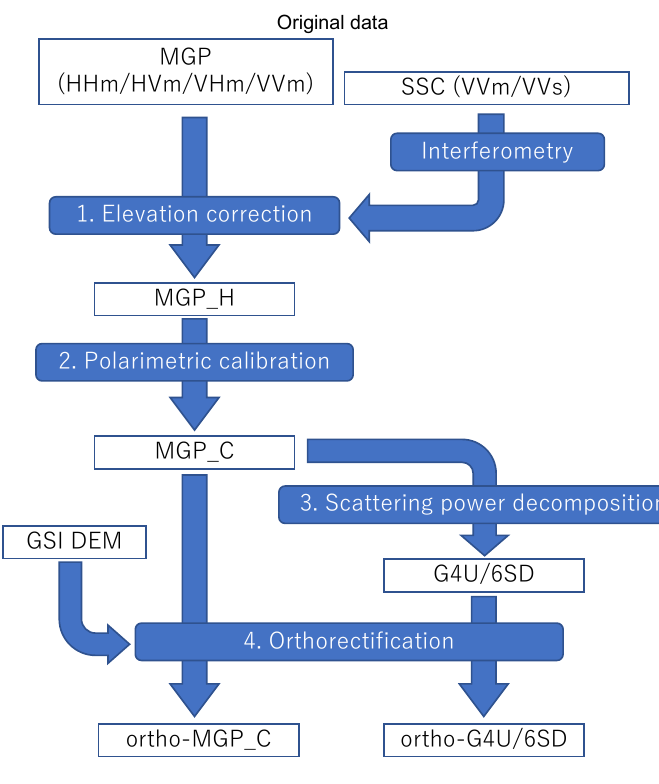
Figure 1. Process